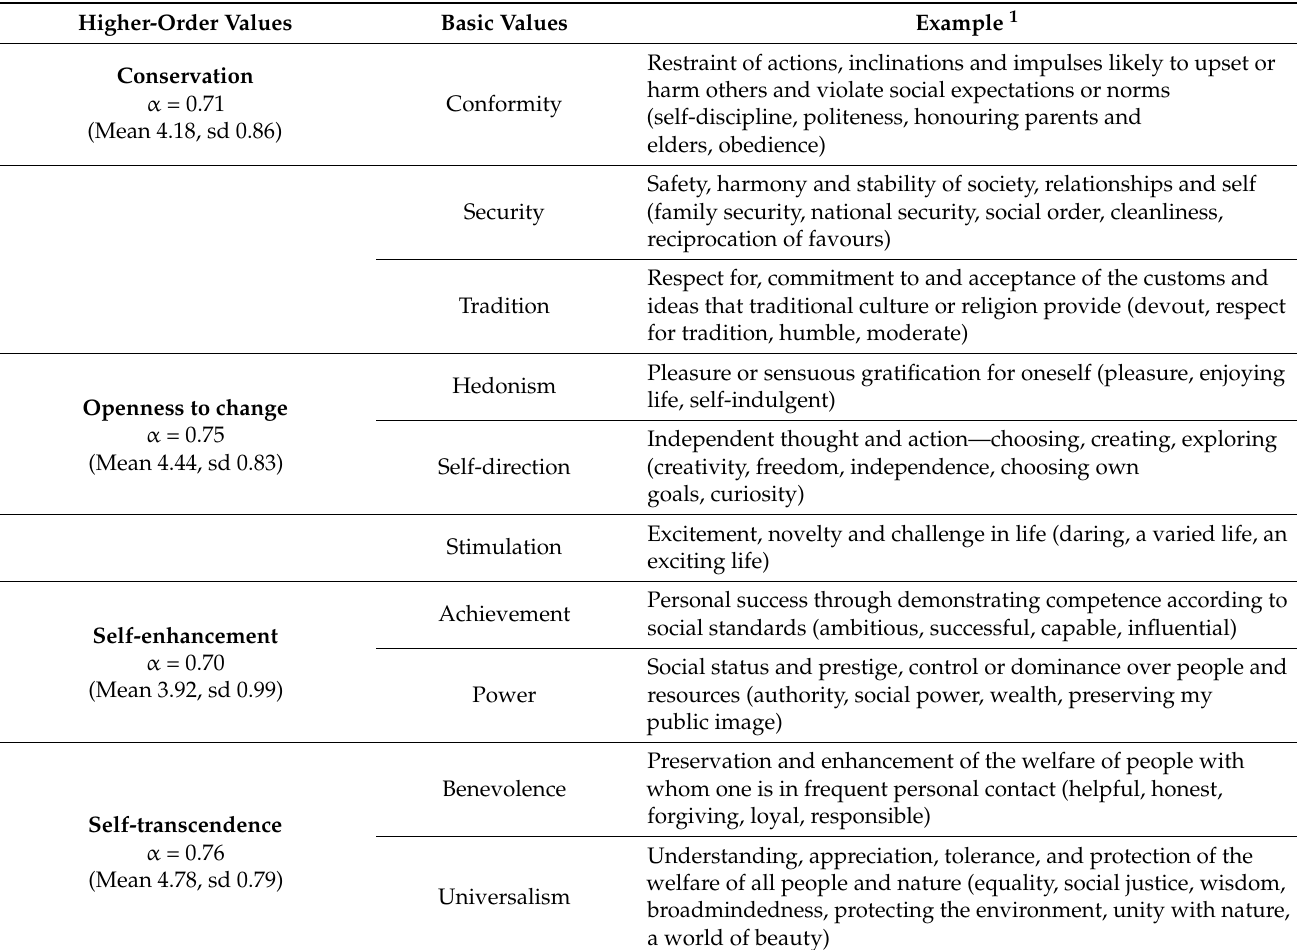
Table 1. Values organised under ten basic values and four higher-order